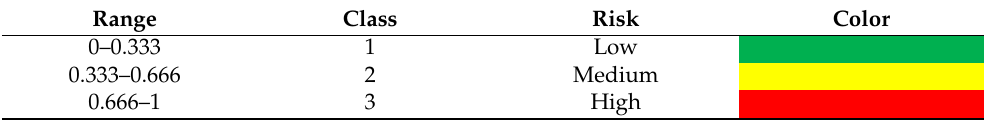
Table 1. Matrix table for discrete reclassification representing the risk indexes for the occurrence of eucalyptus rust ( Austropuccinia psidii ) in the state of Esp í rito Santo.